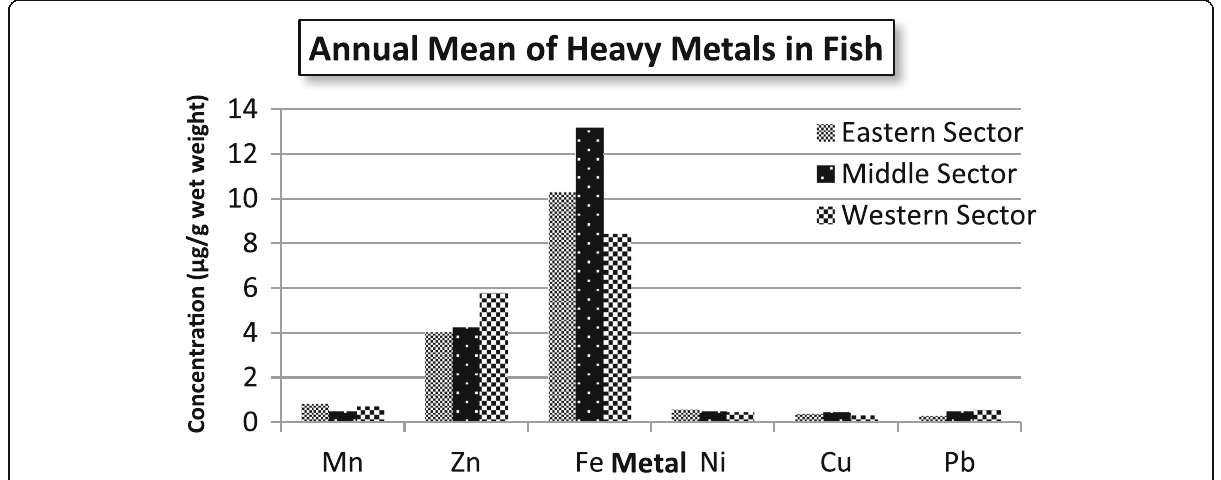
Fig. 3 Annual mean of heavy metals ( μ g/g wet wt.) in O. niloticus muscles at each sector (eastern, middle, and western) of Burullus Lake during